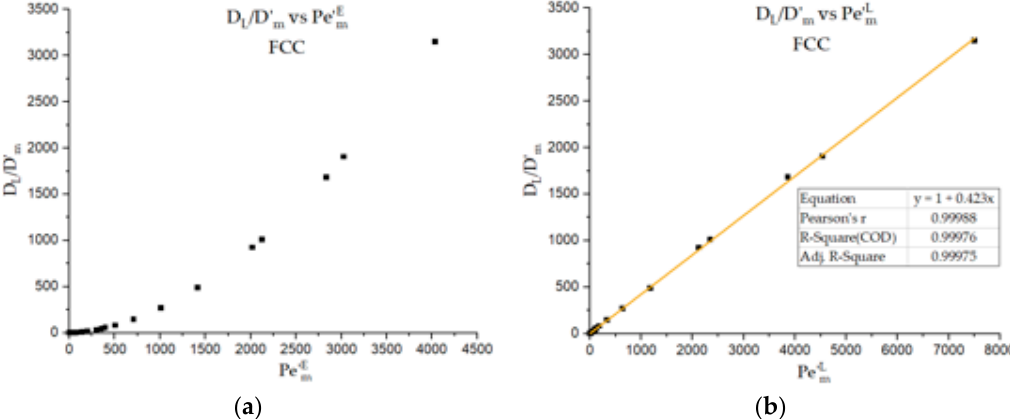
Figure 6. The ratio of the hydrodynamic dispersion coefficient over the effective molecular diffusion coefficient in an FCC-packed bed as a function of the Peclet number: ( a ) the dependence of that ratio on the effective Eulerian Peclet number calculated based on the diameter of the packed spheres and ( b ) the dependence of that ratio on the effective Peclet number determined from the Lagrangian length scale.